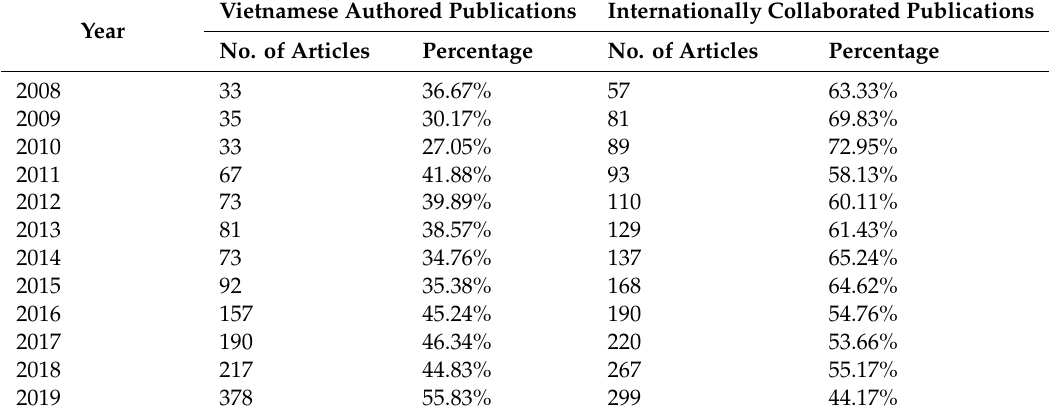
Table 4. Articles whose authors are all Vietnamese vs. articles that have non-Vietnamese authors during the period from 2008–2019 (last updated 30 April